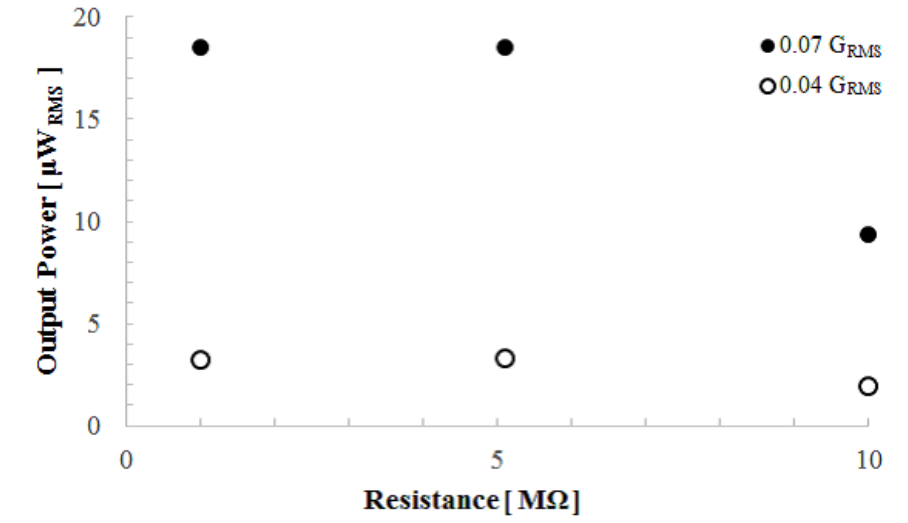
Figure 9. Load resistance dependence of the output power obtained by 0.04 G RMS and 0.07 G RMS external accelerations.